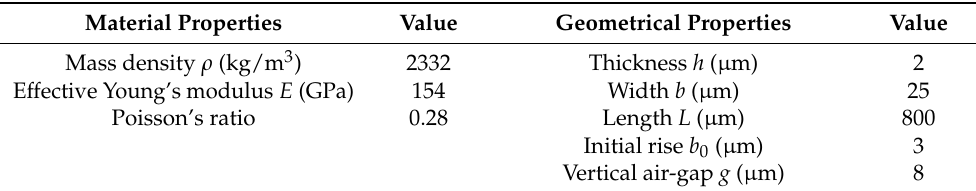
Table 1. Cosine-shaped micro-beam (material and geometrical properties of doped single-Crystal Silicon) for types 1 and 2 of Figure